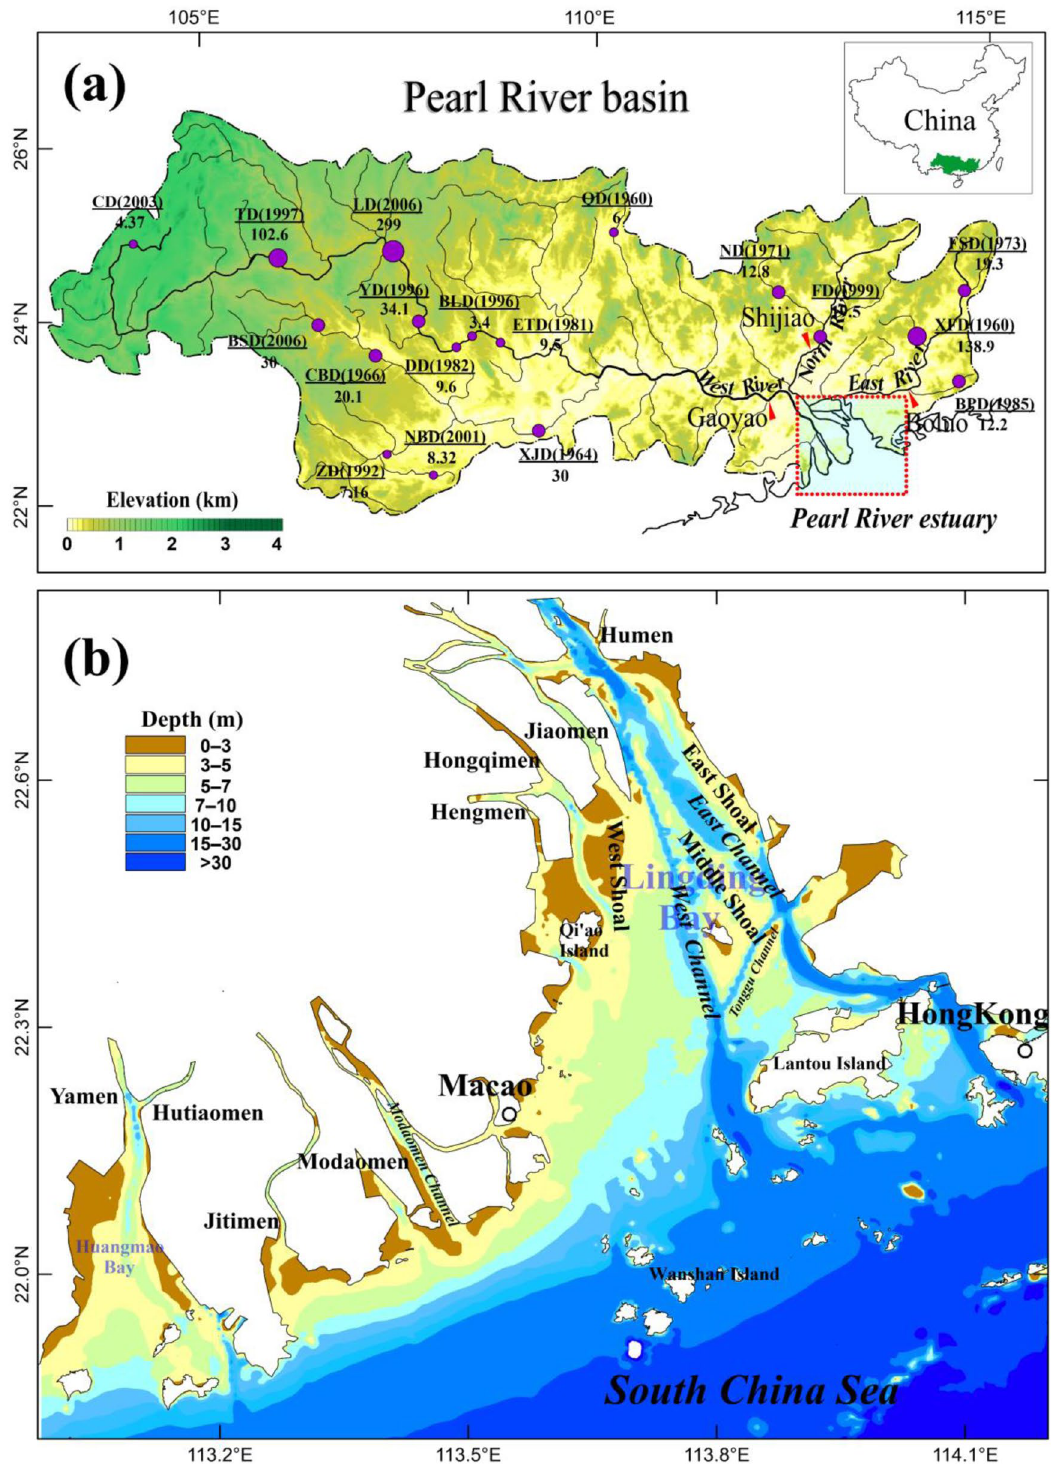
Figure 1. The Pearl River ( a ) and its Estuary ( b ). The index maps of the China and Pearl River basin were modified from Bulletins of Chinese sediment, https:// www. mwr. gov. cn/ sj/. The color scale of the relief map shows the land elevation above the sea level in meters, and the Digital Elevation Model (DEM) data are available at https:// www. ngdc. noaa. gov/ mgg/. Maps were created with Surfer, Version 13, https:// www. golde nsoft ware. com/ produ cts/ surfer, ArcGIS, Version 10.6, https:// deskt op. arcgis. com/ zh- cn. Dam sites are denoted by circles with the name of the dam, year of dam closure in parentheses, and storage capacity of the corresponding reservoir (unit in × 10 8 m 3 ) under each name.